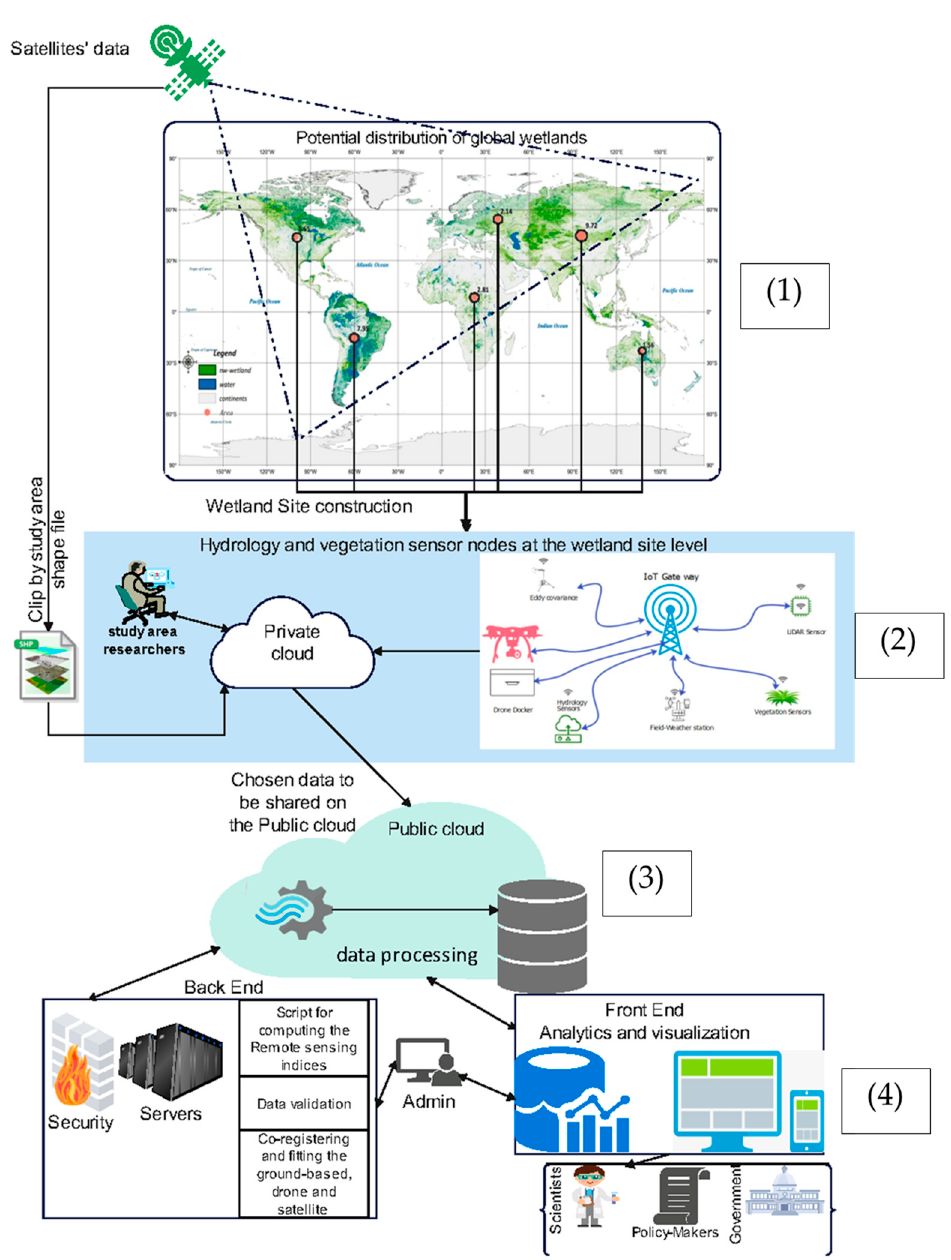
Figure 9. Proposed Cloud Computing structure for the monitoring of globally distributed wetland sites.